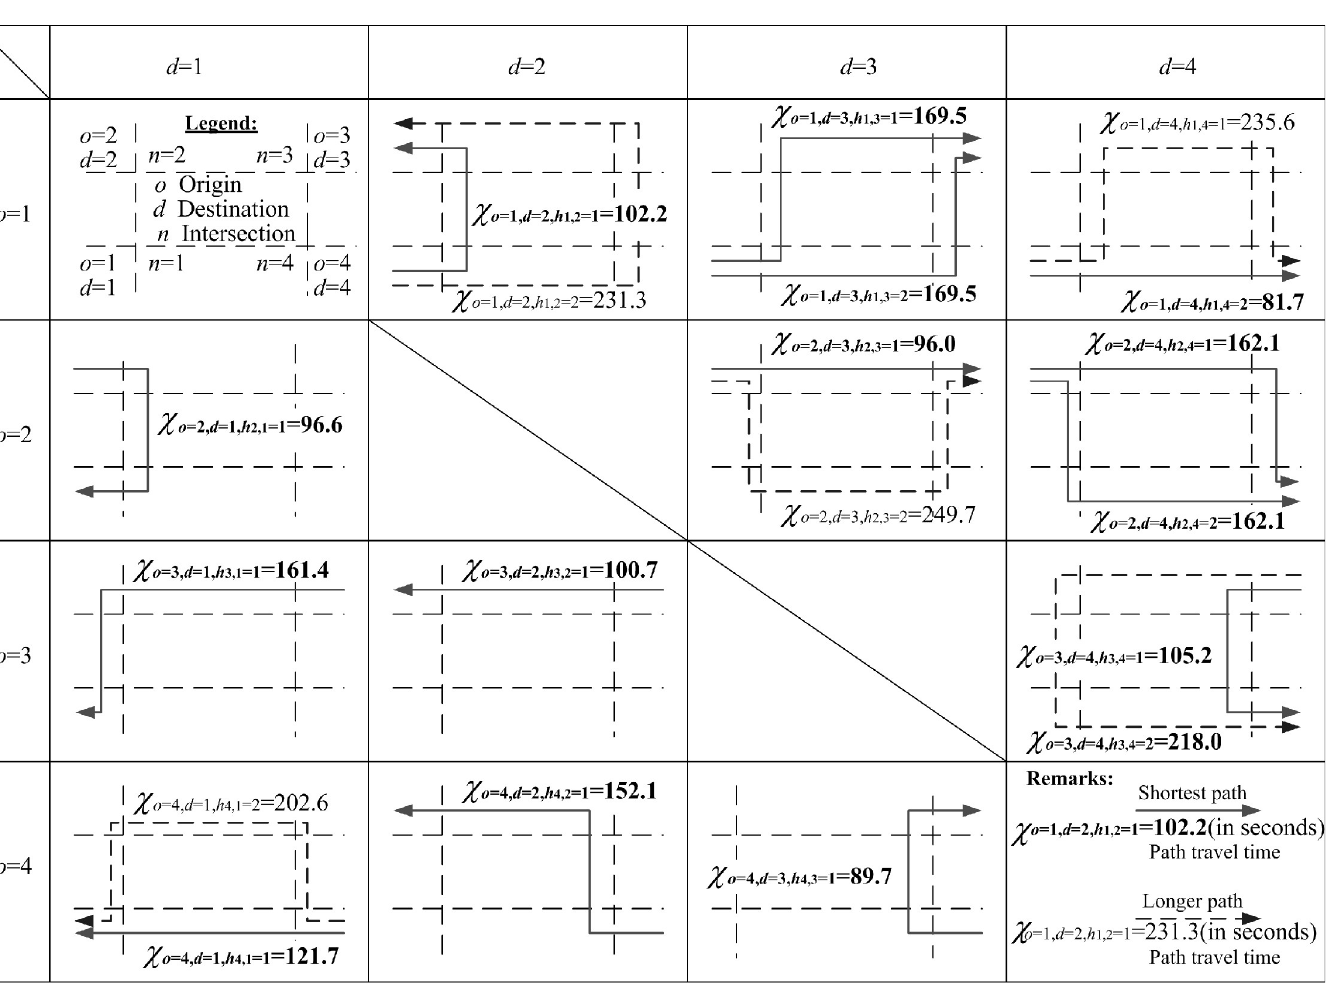
= z ¼ W = z ¼ 32 : 9 s (maximized), m ¼ 1 : 0 and z ¼ 1 = 120 : 0 . a ¼ 2 ; b ¼ 4 ; h a ; b ¼ 1 a ¼ 4 ; b ¼ 2 ; h a ; b ¼ 1